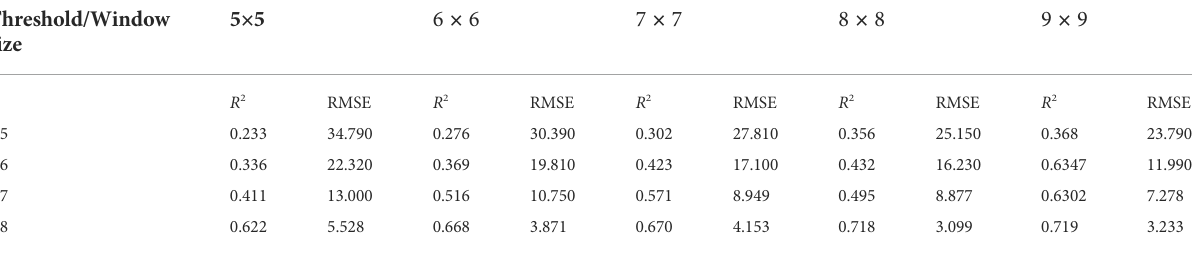
TABLE 6 performance of different sampling window size and threshold at VH channel. Threshold/Window size